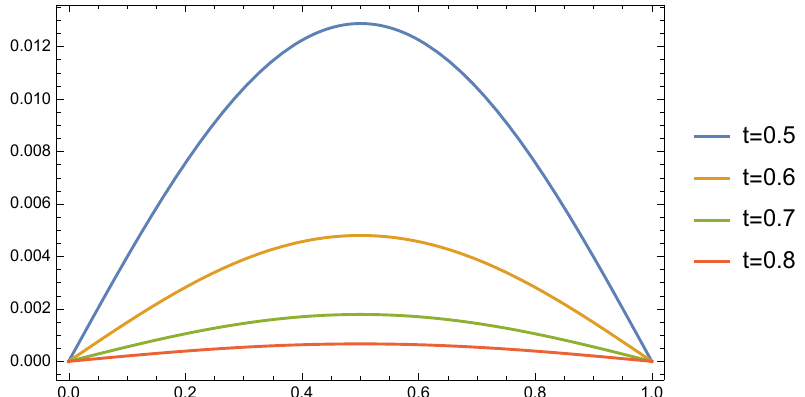
Figure 4. The approximate solutions of Example 2 at different